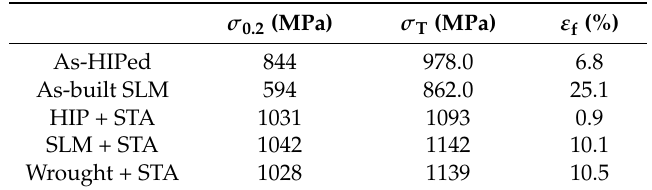
Table 3. Tensile properties at 650 °C.